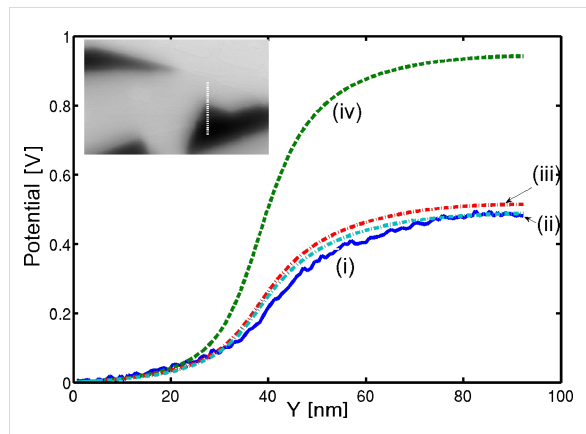
Figure 4: Line section (vertical line at inset figure) for KPFM simula- tion with different cantilever geometries. (i) Original measurements, (ii) W = 40 µm, β = 10° (iii) W = 40 µm, β = 20°, (iv) probe without cantilever with β = 0° (normal to the surface). Inset figure: Single pass